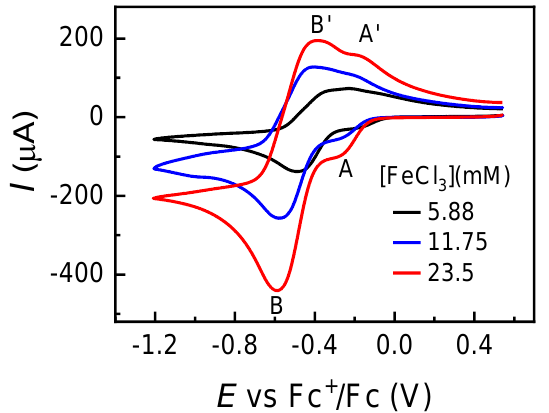
Figure 8. Cyclic voltammetry of FeCl 3 in DMF/MMA (50/50, V/V) + 0.1 M Et 4 NBF 4 recorded on a GC ◦ electrode at v = 0.2 V/s and T = 55 °C. GC electrode at v = 0.2 V/s and T = 55